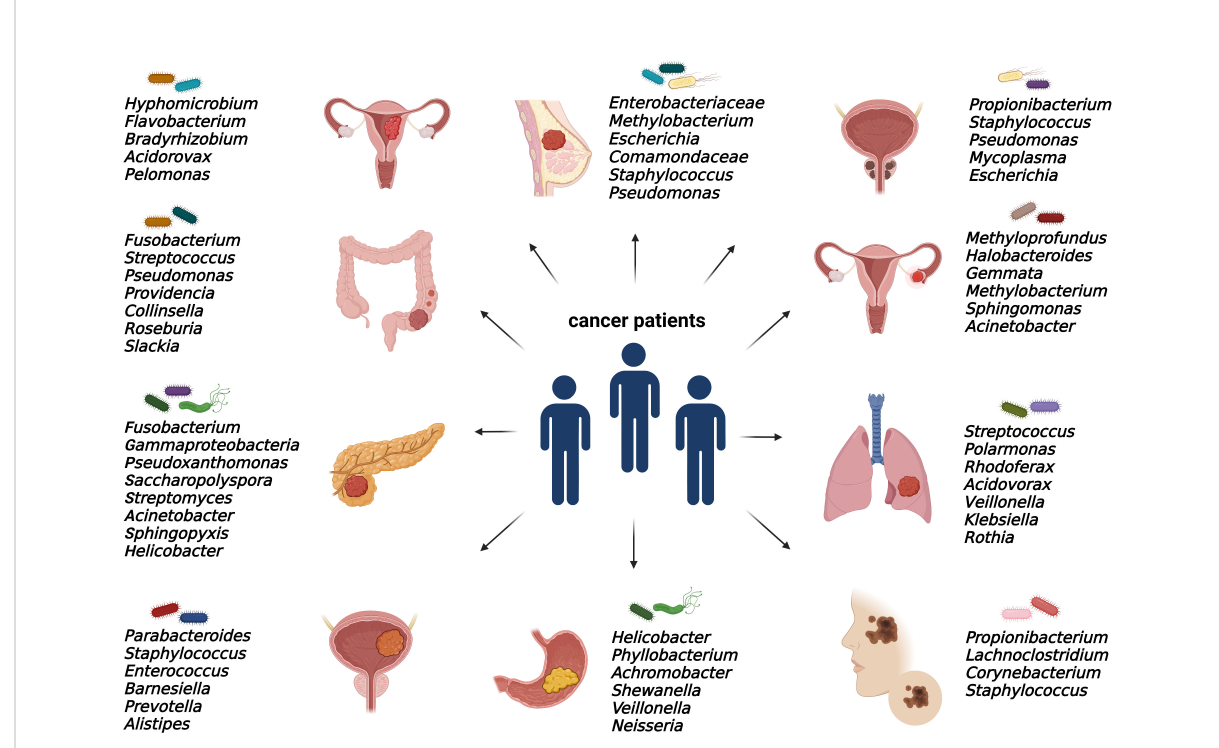
FIGURE 2 Speci fi c intratumoral bacteria within different types of tumors. The presence of cancer type-speci fi c bacteria within the tumor microenvironment was revealed mainly by 16S rRNA or metagenomic sequencing and via immunohistochemical and immuno fl uorescence detection